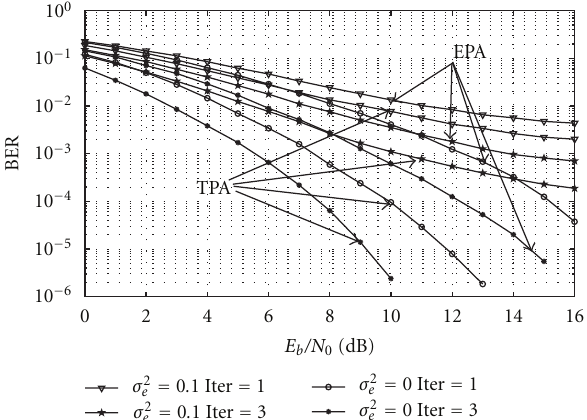
Figure 5: BER performance of traditional and modified Turbo- BLAST systems with four transmit and four receive antennas under the conditions of di ff erent inaccuracy of channel